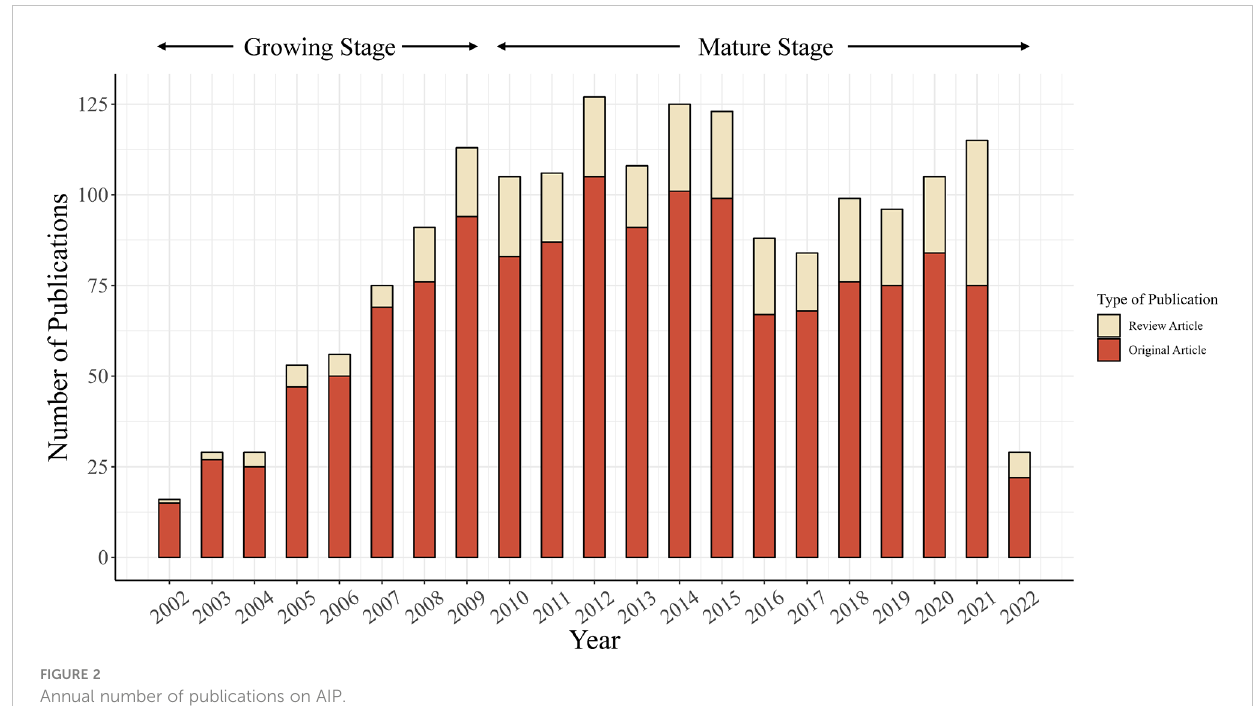
FIGURE 2 Annual number of publications on